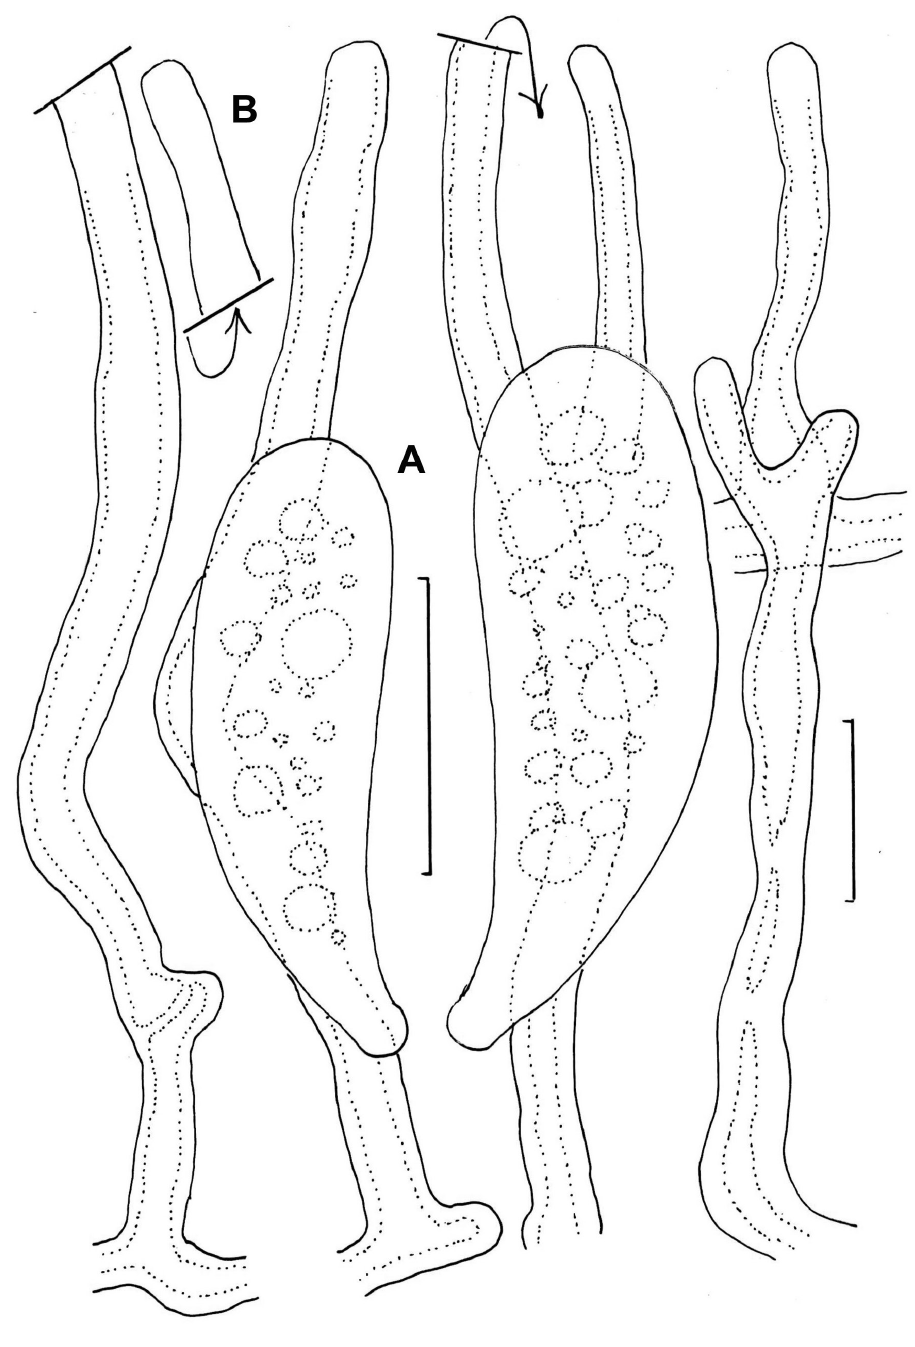
Figure 25. Mycetinis copelandii . A Basidiospores B Caulocystidia from upper stipe. Standard bars: A = 5 µm; B = 20 µm. TFB 8084